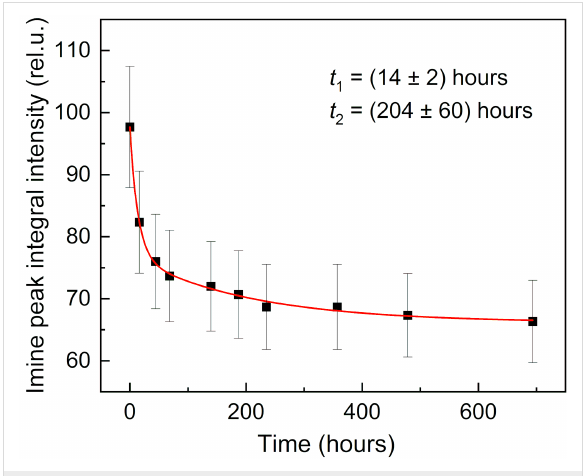
Figure 3: The integrals of the imine group proton signal at 8.30 ppm in the acquired 1 H NMR spectrum of compound 3d at pH 9 as a function of time. Time constants t 1 and t 2 correspond to the fast and slow com- ponents of the double-exponential decay function. The red line is the corresponding fit of the experimental data by Equation 1.